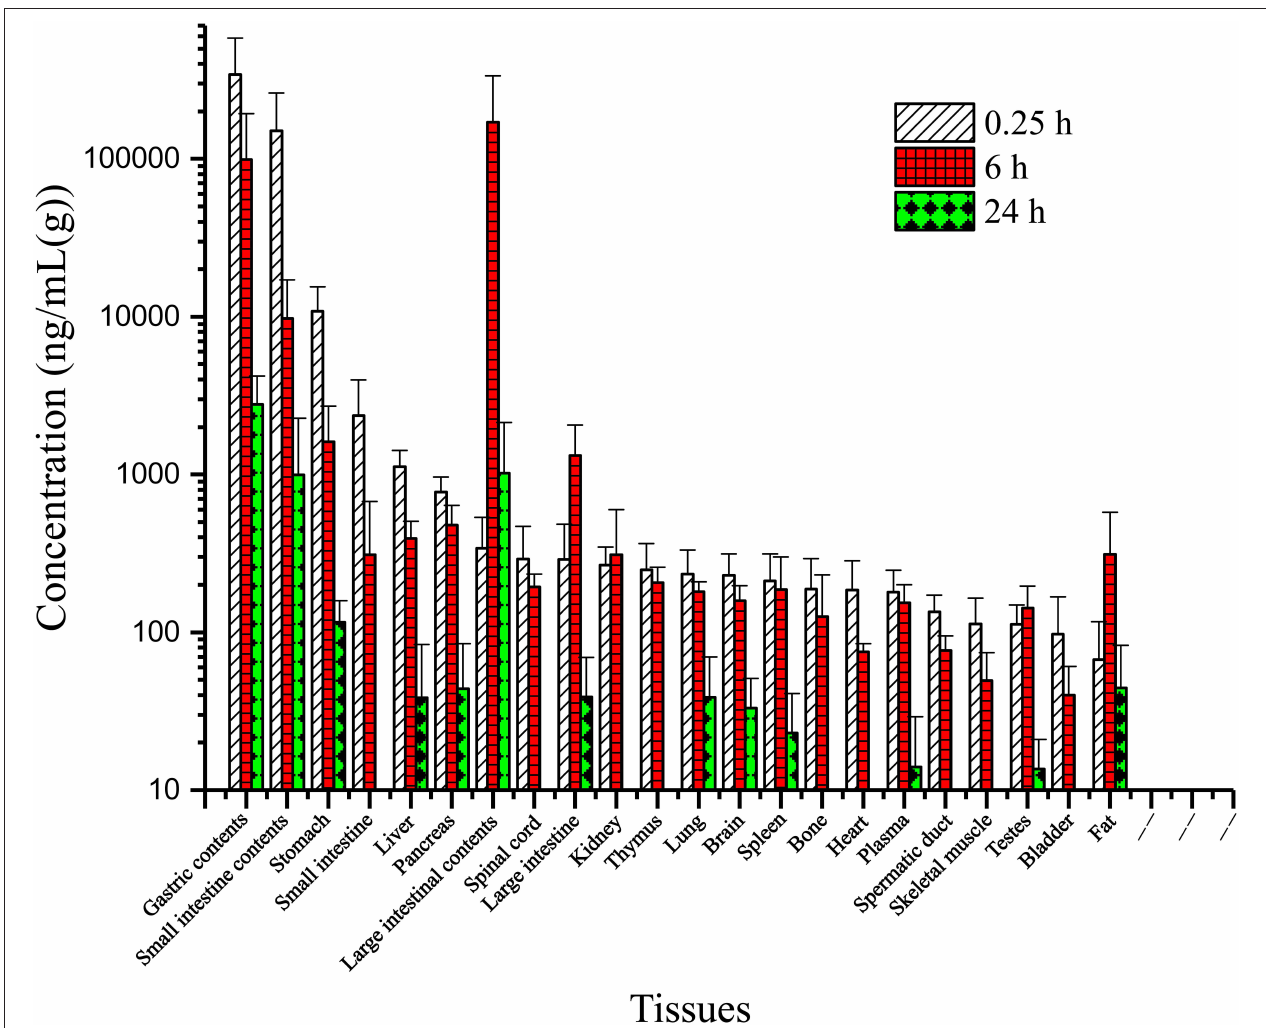
FIGURE 3 | Tissue distribution of vitacoxib in rats after a single oral gavage dose of 18 mg/kg bw.